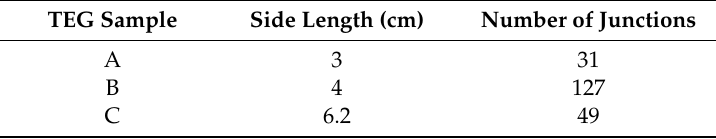
Table 1. Side length and number of junctions of the thermoelectric generator (TEG) samples investigated. TEG Sample Side Length (cm) Number of Junctions A 3 6.2 49